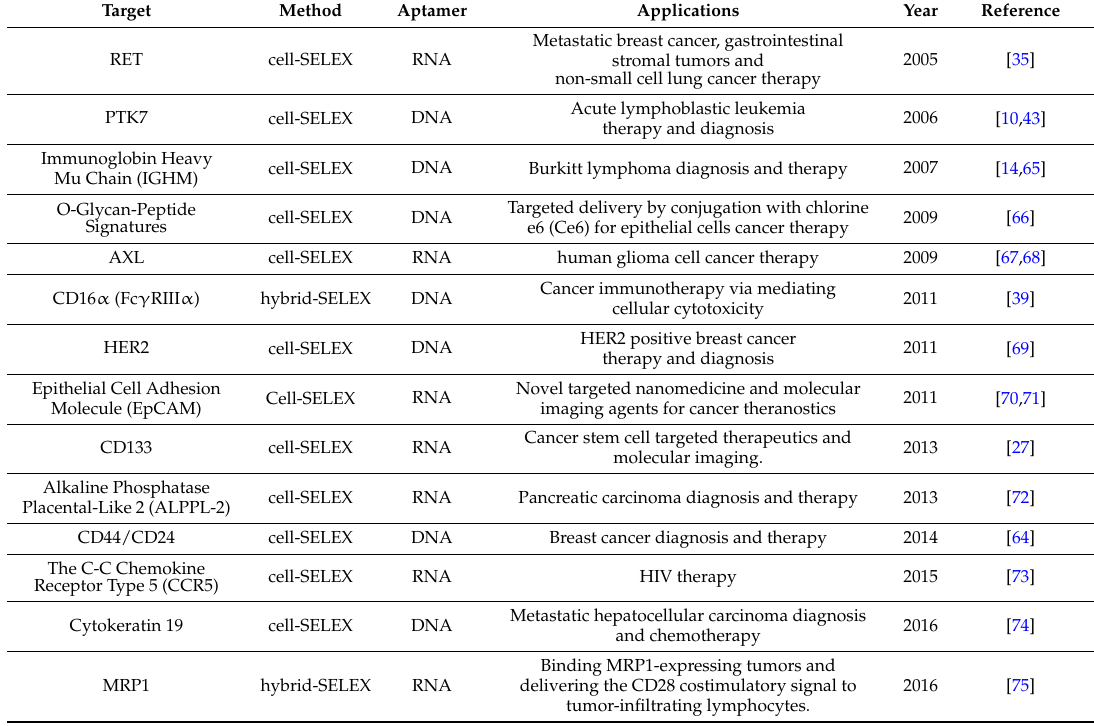
tumor-infiltrating